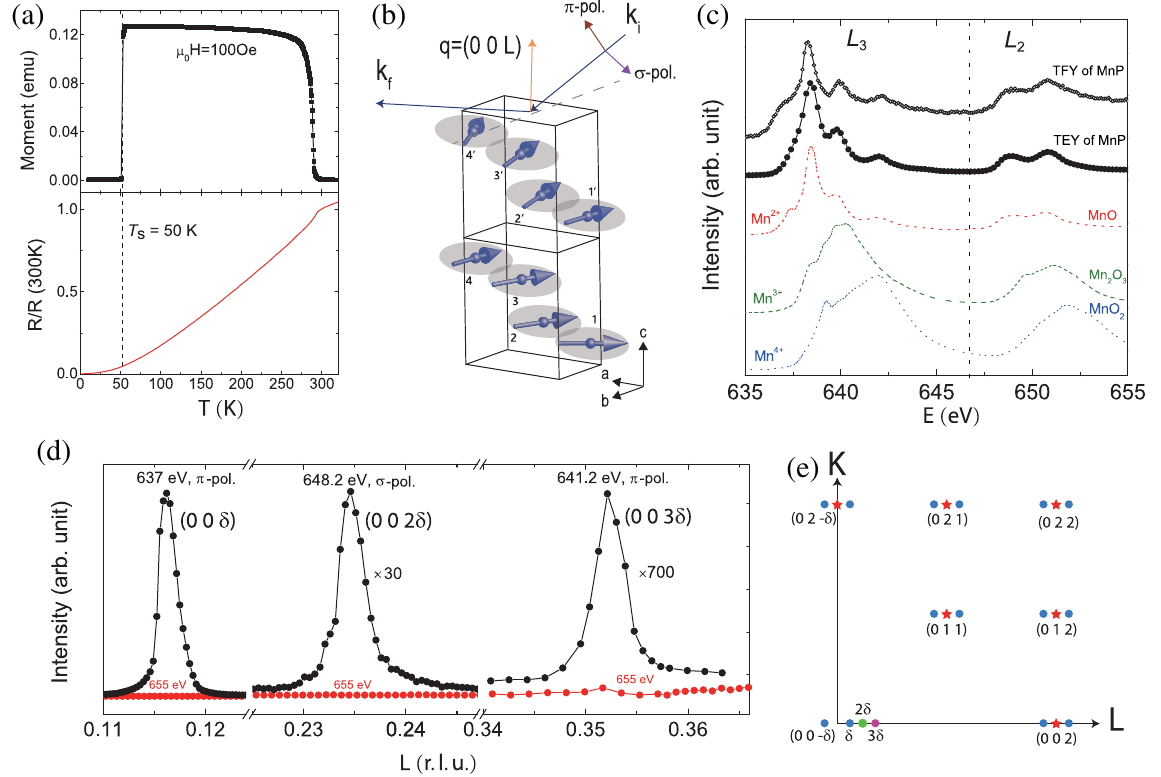
FIG. 1. Basic properties and x-ray diffraction peaks of MnP. (a) Magnetic susceptibility and resistance data of the MnP single-crystal sample. (b) Schematic illustration of the helical spin order and the RSXS scattering geometry. The spin rotates about 21° between Mn1 and Mn2, and between Mn3 and Mn4, giving an incommensurate double helical spin order, or a helical spin density wave (SDW), with a period of about 8 . 6 c . Mn1 and Mn3 spins form one spin helix, and Mn2 and Mn4 spins form the other. The incident x ray is linearly polarized. (c) X-ray absorption spectroscopy (XAS) of MnP (solid black dots) and three reference compounds MnO (dashed red line), Mn 2 O 3 (dashed olive line), and MnO 2 (dashed blue line) around the Mn L edge. The reference spectra are obtained on beam line 8.0.3 at the Advanced Light Source [14] and are plotted here offset by 1.55 eV in order to match our MnP spectrum obtained at the SSRL. The Mn L -edge XAS of MnP is characteristic of Mn 2 þ ions. The hollowed black dots represent the bulk sensitive total fluorescence yield (TFY) spectra of MnP which is simultaneously measured with the TEY spectra. (d) Scattering peaks around q 1 ¼ ð 0 0 0 . 116 Þ r : l : u : , q ¼ ð 0 0 0 . 234 Þ r : l : u : , and q ¼ ð 0 0 0 . 352 Þ r : l : u : at resonant energies (black dots) and nonresonant energy (red dots, E ¼ 655 eV) at 2 3 20 K. q 1 and q 2 signals are measured by a Schottky barrier photodiode, and the q 3 signals are measured by a quantum-efficient channeltron. The three resonant peaks represent the strongest resonant signals at each q position (see Fig. 3). (e) Schematic diagram of the location of the diffraction peaks in MnP including lattice peaks (red stars), magnetic peaks (blue dots), and the newly discovered resonance peaks in this paper (green and magenta